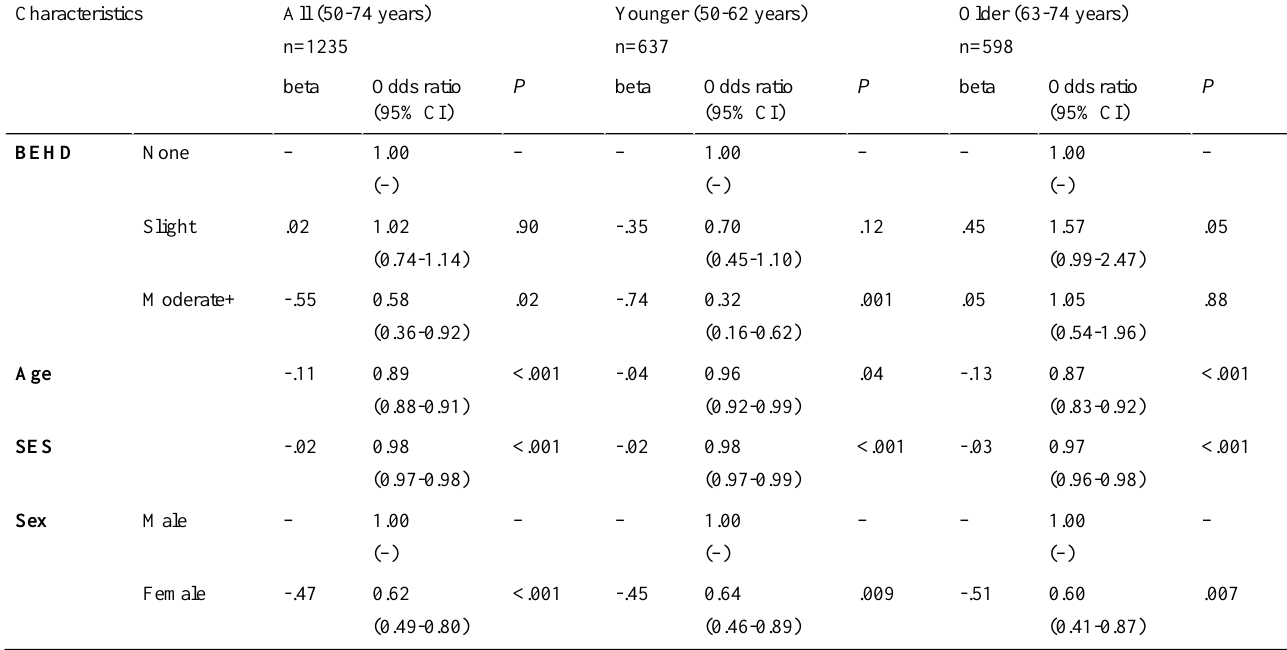
Table 4. Logistic regression coefficients (beta) and odds ratio estimates from the multivariate logistic regression model for factors affecting Internet